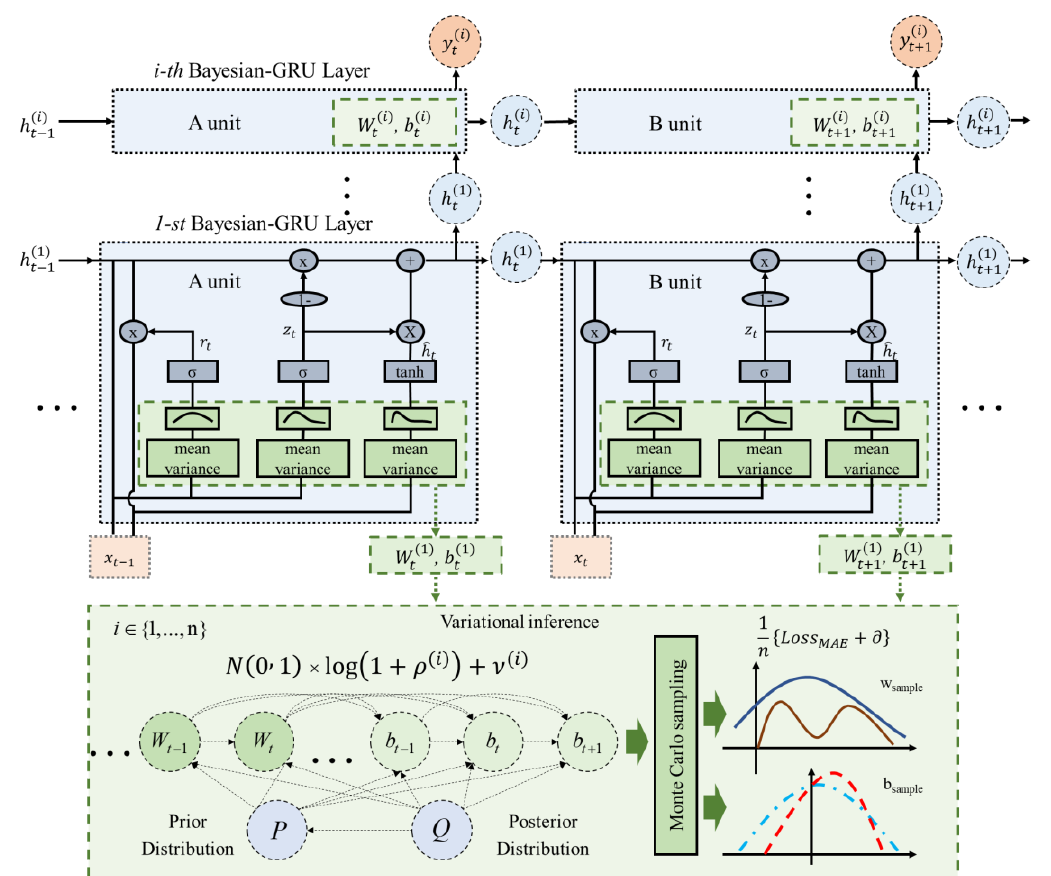
Figure 2. Bayesian-GRU structure. The blue box in the figure shows our proposed Bayesian-GRU module, the pink box shows the input temperature data, x t , and the output, y t , predicted by the model, and the blue circle, h t , shows the hidden state information at the current moment. W t and b t are the weights and biases within the GRU, which we incorporated into the Bayesian variational inference (as shown in the green box). W t and b t are no longer specific values; we transformed them by translation and scaling, using a Gaussian distribution with mean µ and standard deviation σ .